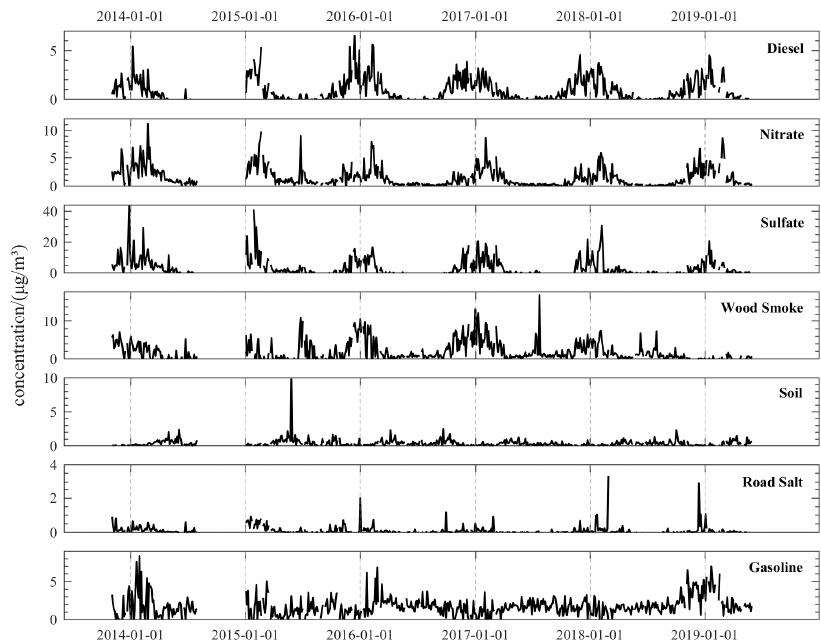
Figure 8. Temporal variations of PM 2.5 source concentrations. Dashed lines represent 1 January of each year.